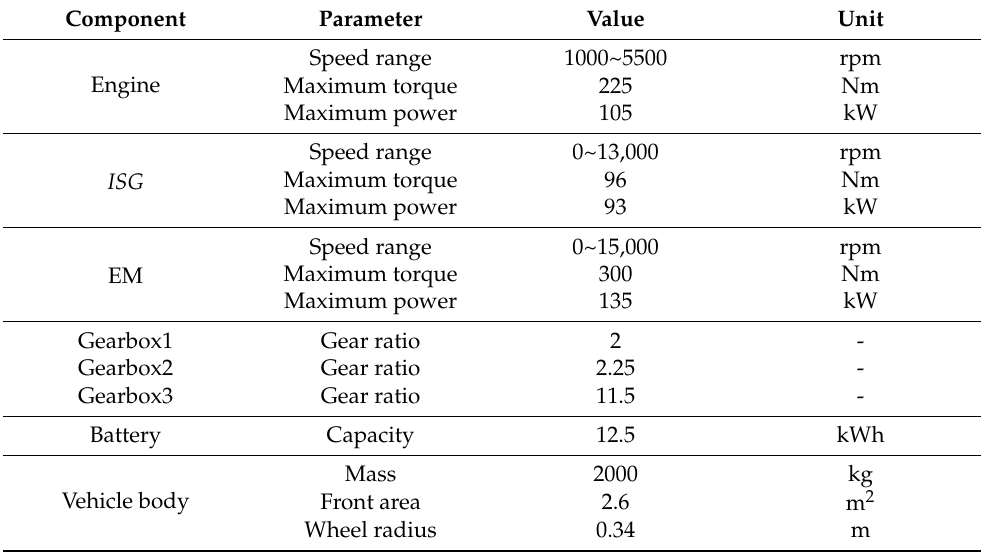
Table 1. HEV parameters.